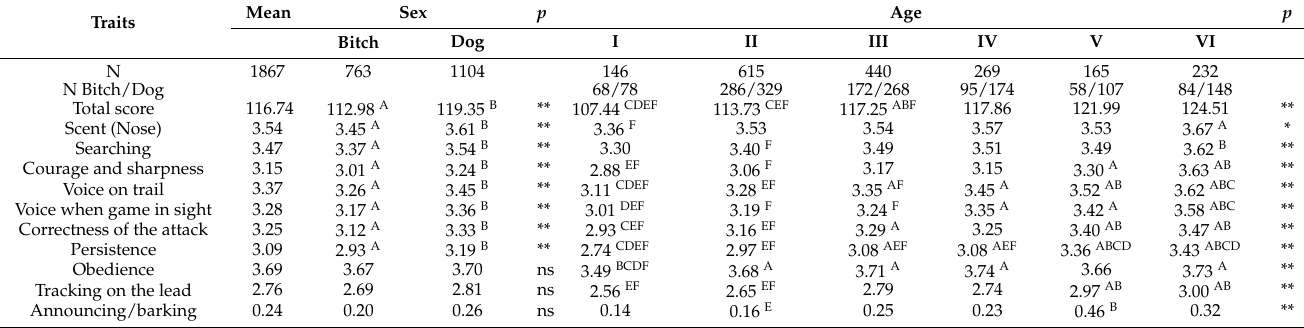
tracking on the lead, and announcing/barking ( p > 0.05). Table 3. The impact of sex and age on the results of the hunt trials for